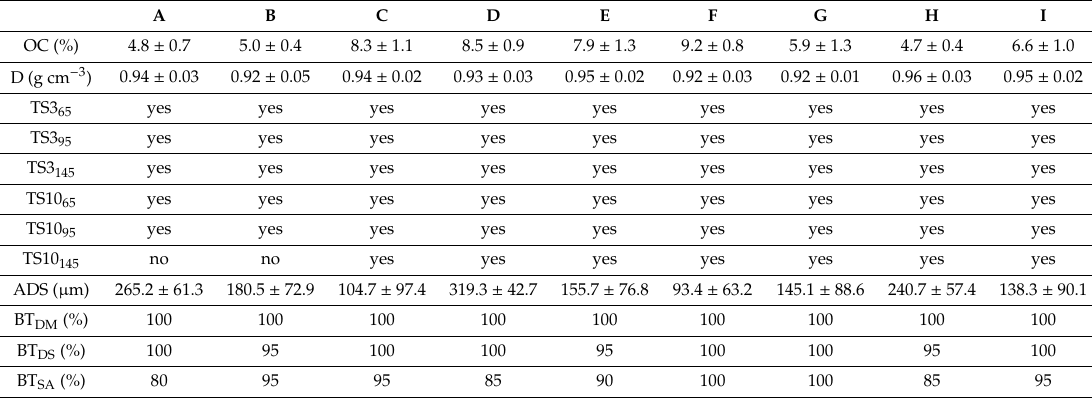
Table 1. Characteristics of the emulsion samples (A–I), where: OC = oil content; D = density; TS10 = thermal stability (at 65, 95 and 145 ◦ C) after alkali treatment; TS3 = thermal stability (at 65,